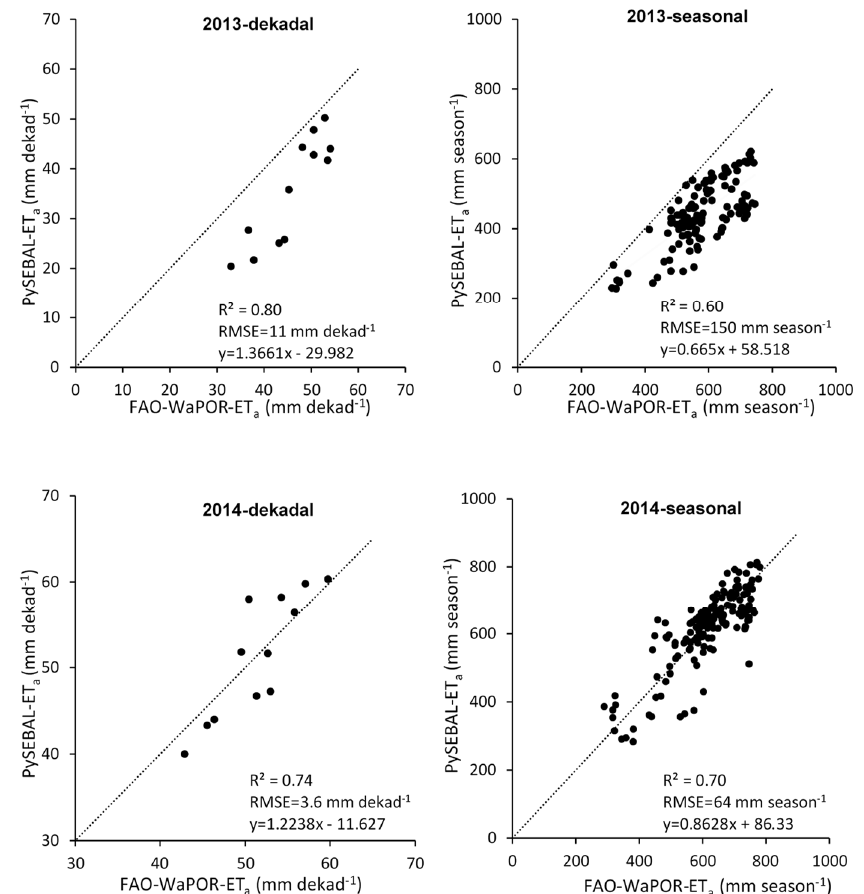
Figure 5. Comparisons between the Food and Agricultural Organization of the United Nations Water Productivity (FAO-WaPOR) and Python module for the Surface Energy Balance Algorithm for Land model (PySEBAL) derived actual evapotranspiration (ET a ) at the dekadal and seasonal scales at the Kou Valley irrigation scheme during the dry season production period in 2013 and 2014. Comparisons at the dekadal scale were performed for the entire irrigation scheme, while those at the seasonal scale were performed on a pixel basis for the entire scheme. Dashed lines in the sub-figures represent the 1:1 line.